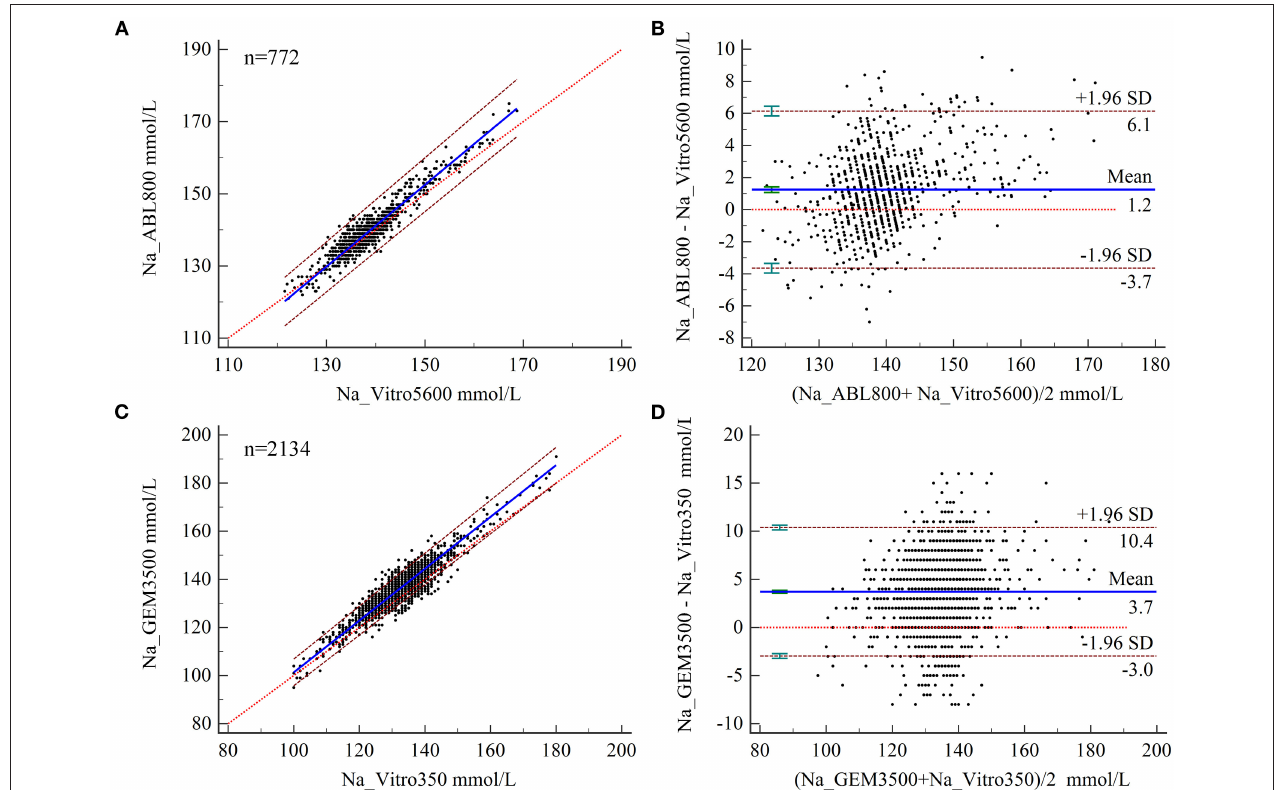
FIGURE 2 | (A,B) Scatter diagrams showing the results of Passing–Bablok regression analysis of the comparisons of sodium (Na) levels in arterial blood and venous serum samples between the ABL800 FLEX and VITROS5600 systems (A) and the GEM3500 and VITROS350 systems (B) . The graph shows the observations together with the regression line (solid blue line), the confidence interval for the regression line (dashed lines), and the identity line ( x = y , dotted line). (B,C) Results of Bland–Altman analysis of the comparisons of Na levels measured in blood and venous serum samples between the ABL800 FLEX and VITROS5600 systems (C) and between the GEM3500 and VITROS350 systems (D) showing the 95% limits of agreement (LoA). The scatter diagram shows the differences plotted against the averages of the two measurements. Horizontal lines are drawn at the mean difference and the